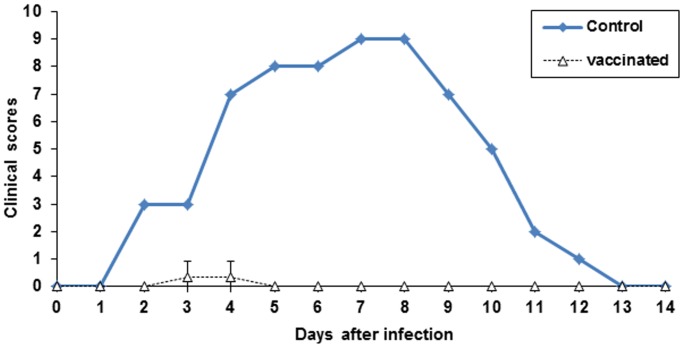
Clinical scores of vaccinated and control goats following CpHV-1 vaginal challenge.